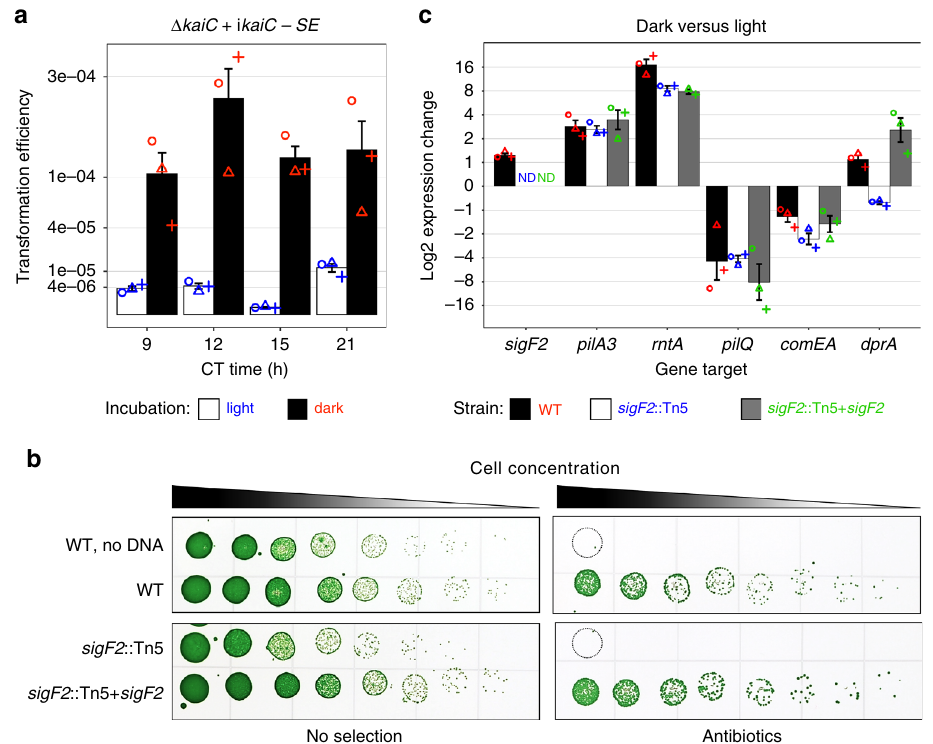
Fig. 4 The timing of natural competence is controlled by the phosphorylation state of KaiC and requires SigF2-dependent expression of DprA. a Transformation ef fi ciency at 4 time points over a 24-h circadian cycle of Δ kaiC complemented with a mutant kaiC-SE phosphomimetic allele that mimics the dusk phosphorylation state of KaiC. Ef fi ciencies were calculated as the number of antibiotic-resistant colonies per CFU without selection upon transformation of three biologically independent cultures (circles, triangles, and plus signs) and plotted as mean values ± SEM on a square-root scale. b Transformation assays performed on knockout and complemented strains of sigF2 . WT S. elongatus PCC 7942 with and without added eDNA served as controls. The assay was performed using three independent clones for each strain, which yielded similar results. c Expression analysis of selected T4PM and competence genes in a sigF2 knockout strain, a sigF2 complemented strain, and a WT control measured by RT-qPCR on cultures collected 2 h after circadian dusk with cells that went into the dark at ZT 12 or were maintained in light. Fold-changes were calculated as 2 − ΔΔ Ct in dark relative to light conditions for three biologically independent cultures (circles, triangles, and plus signs) of each strain and plotted as mean values± SEM. The expression of sigF2 by RT-qPCR was not determined (ND) in the sigF2 knockout and sigF2 complemented strains. Source data are provided as a Source Data fi